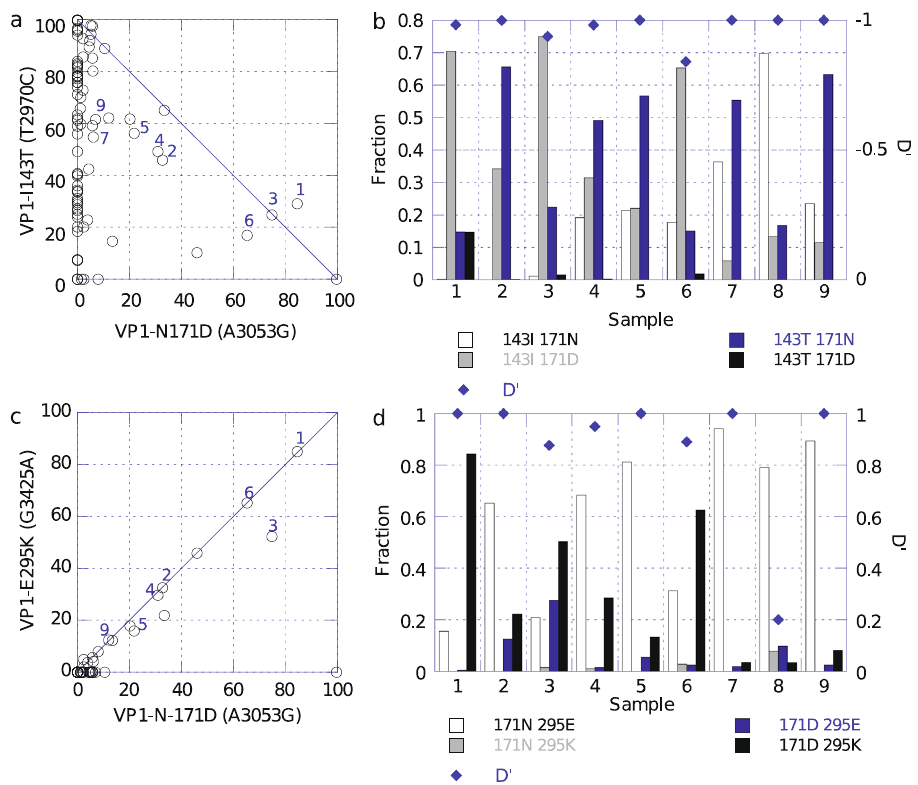
Fig. 4 Relationship between VP1-I143T, VP1-N171D and VP1-E295K in nOPV2-c1 shed virus samples. a Levels of T2970C (VP1-I143T) and G3053A (VP1-N171D) in individual replicates from 31 EES. Numbered symbols correspond to the sample number in panel b . b Colocation of 143T and 171D in nine samples from three study participants. c Levels of A3053G (VP1-N171D) and G3425A (VP1-E295K) in individual replicates from 31 EES. Numbered symbols correspond to the sample number in panel d . d Colocation analysis for 171D and 295K in the same nine samples as panel b